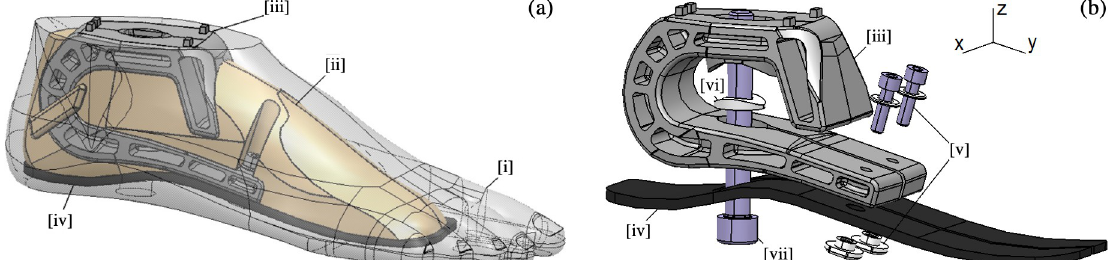
Fig 4. Design of the prototype foot. (a) Representation of the prototype foot composed of (i) a cosmetic shell, (ii) a filling foam, (iii) an ankle, and (iv) a blade. (b) PP Technology’s bolting system to connect the foot to the rest of the prosthetic leg composed of (v) an M10 bolt and (vi) a specific washer, (vii) ankle, and blade fixation with M5 bolts and inserts.